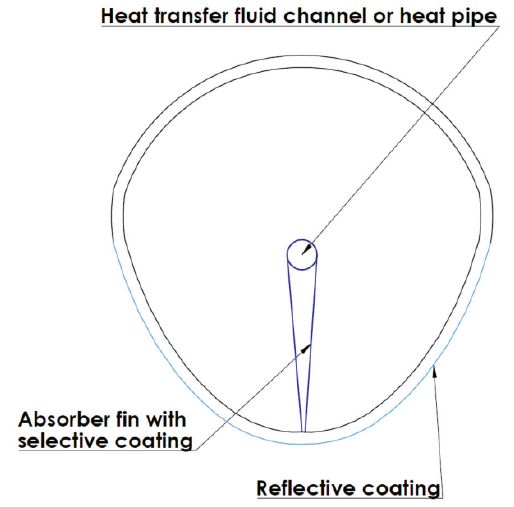
Figure 24. New integrated CPC (ICPC) design showing vertical and horizontal fin orientations [54].